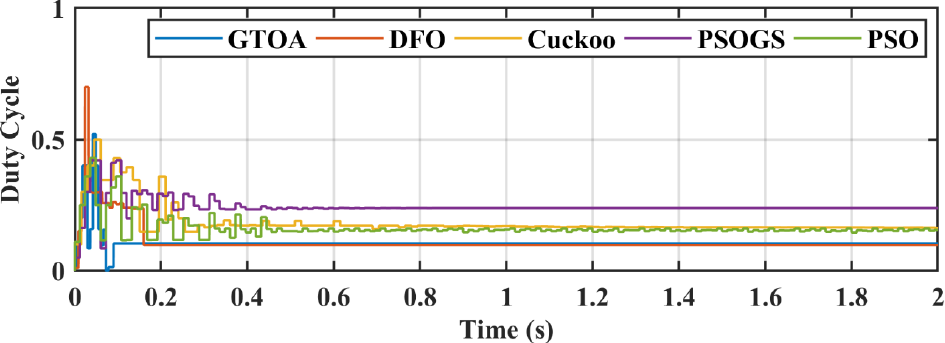
Figure 29. Comparison of duty cycle of GTOA.